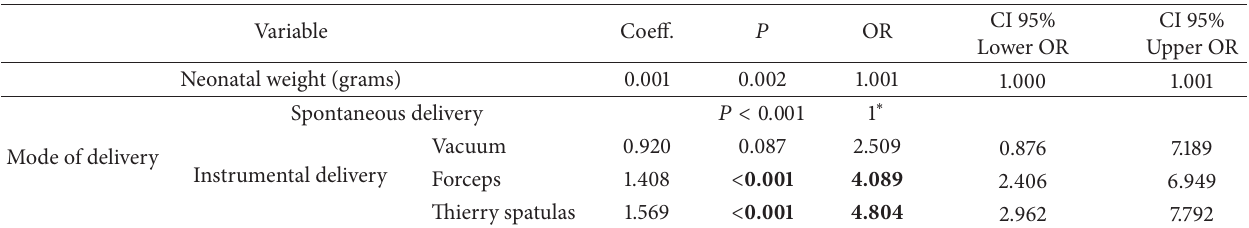
Table 4: Summary of multivariate analysis